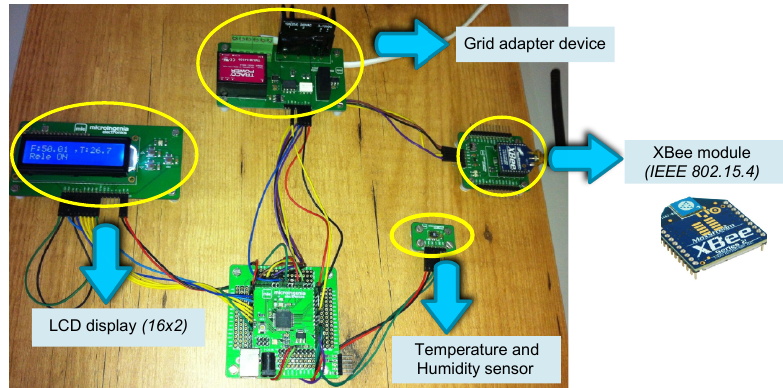
Figure 5. Example of real implementation (laboratory